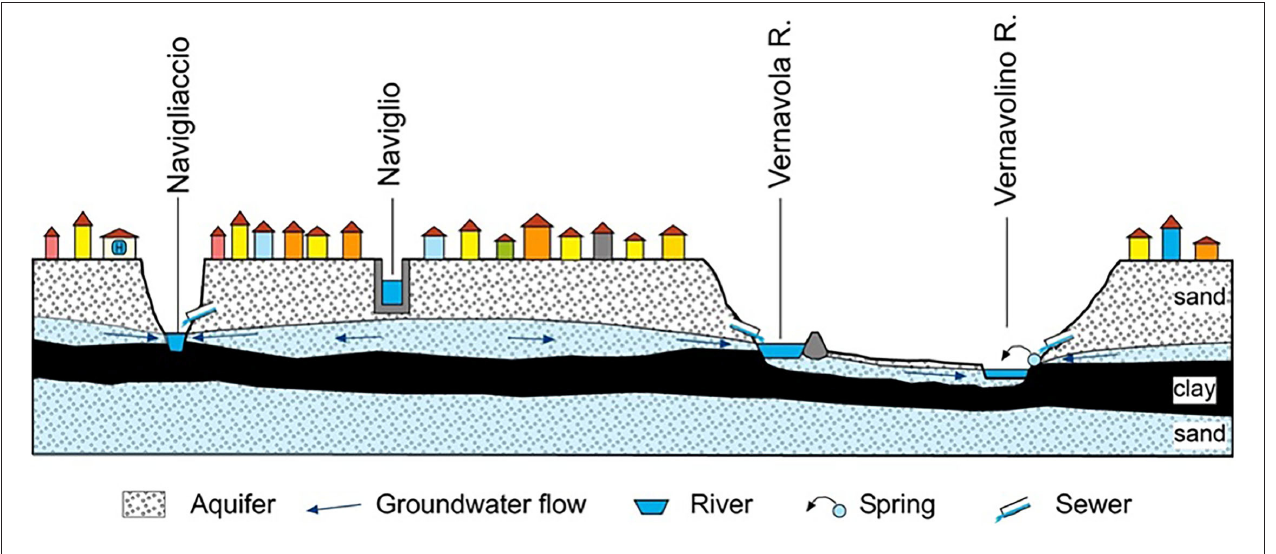
FIGURE 2 | Schematic hydrogeological section through the city of Pavia.